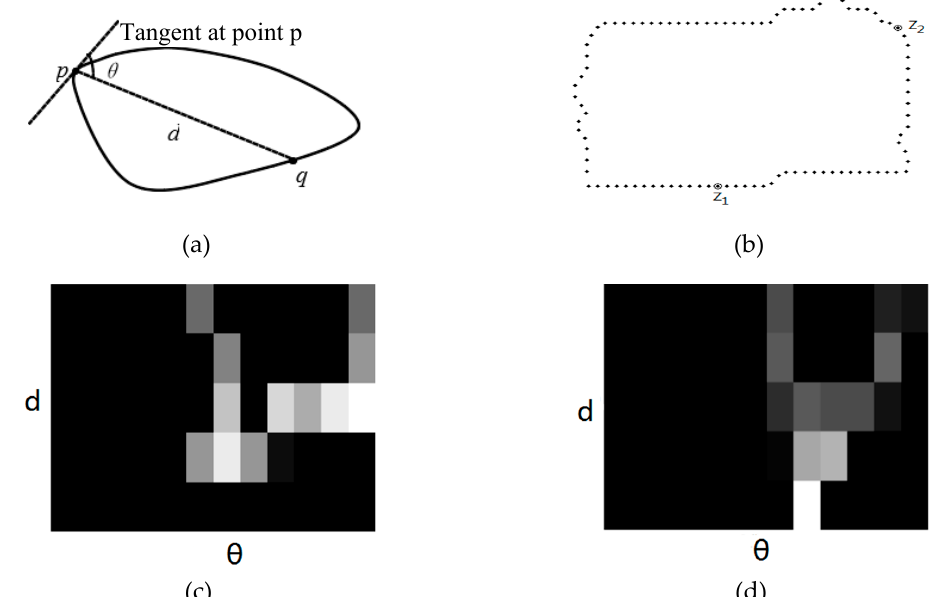
Figure 3. Establishment of shape context histograms, including ( a ) the inner-distance and the inner-angle, ( b ) sampled edge points of a building, ( c ) shape context histogram of the sample point Z 1 , and ( d ) shape context histogram of the sample point Z 2 .